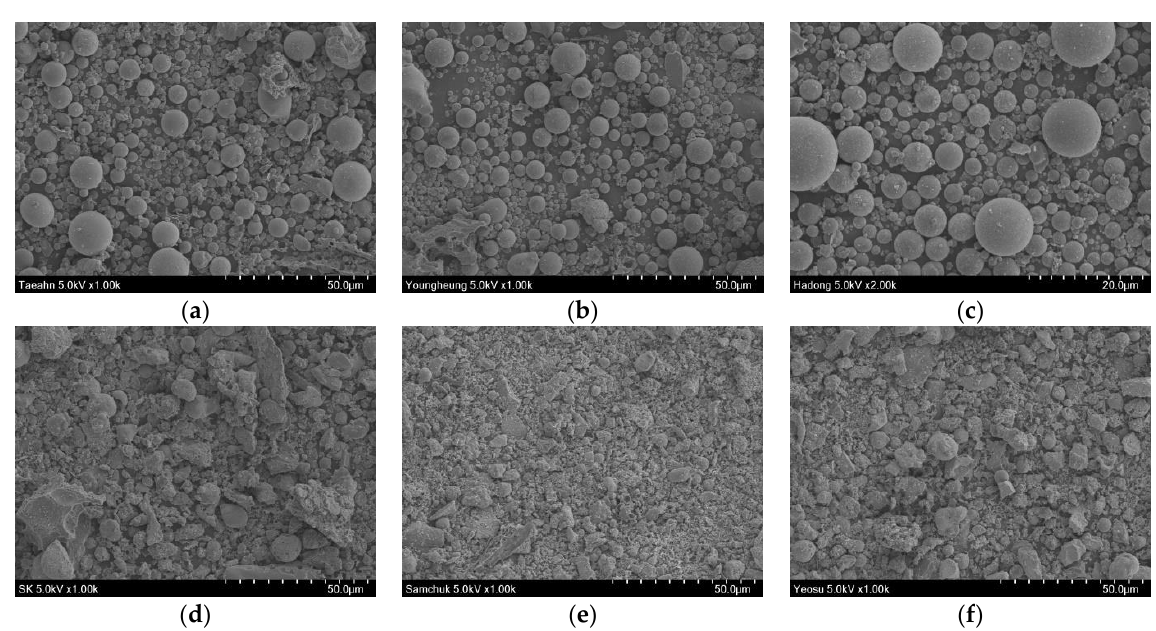
Figure 1. Scanning electron microscope images of fly ashes used in this study—( a ) F1; ( b ) F2; ( c ) F3; ( d ) F4; ( e ) F5; ( f ) F6.